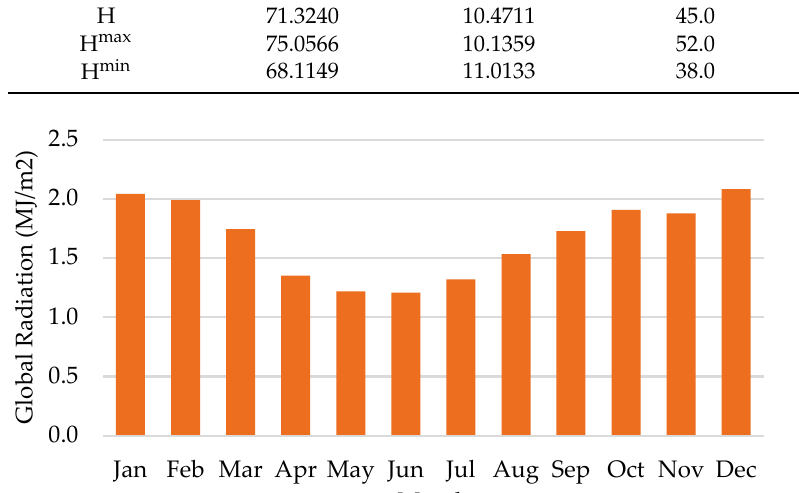
Figure 2. Average monthly solar radiation from January 2015 to August 2021 in Salvador, Brazil.